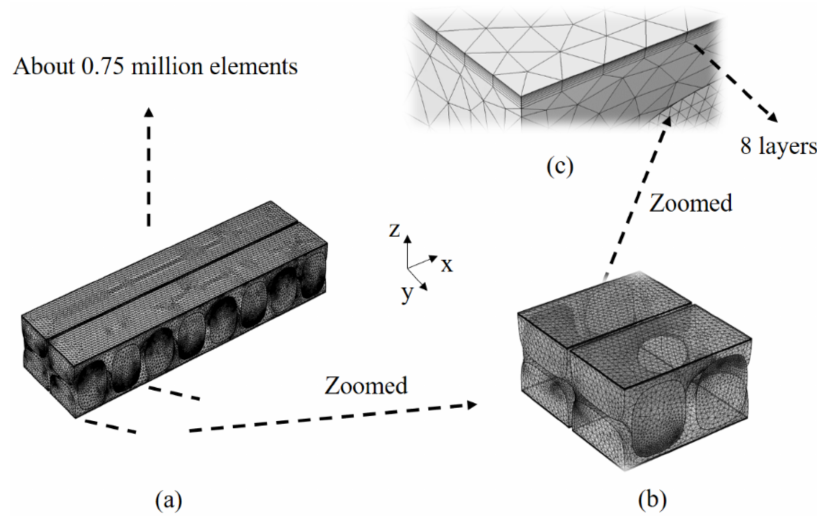
Figure 4. ( a ) Discretization model (CLP) of the whole computational domain ( ≈ 0.75 million elements), ( b ) a spacer unit, and ( c ) zoomed spacer unit